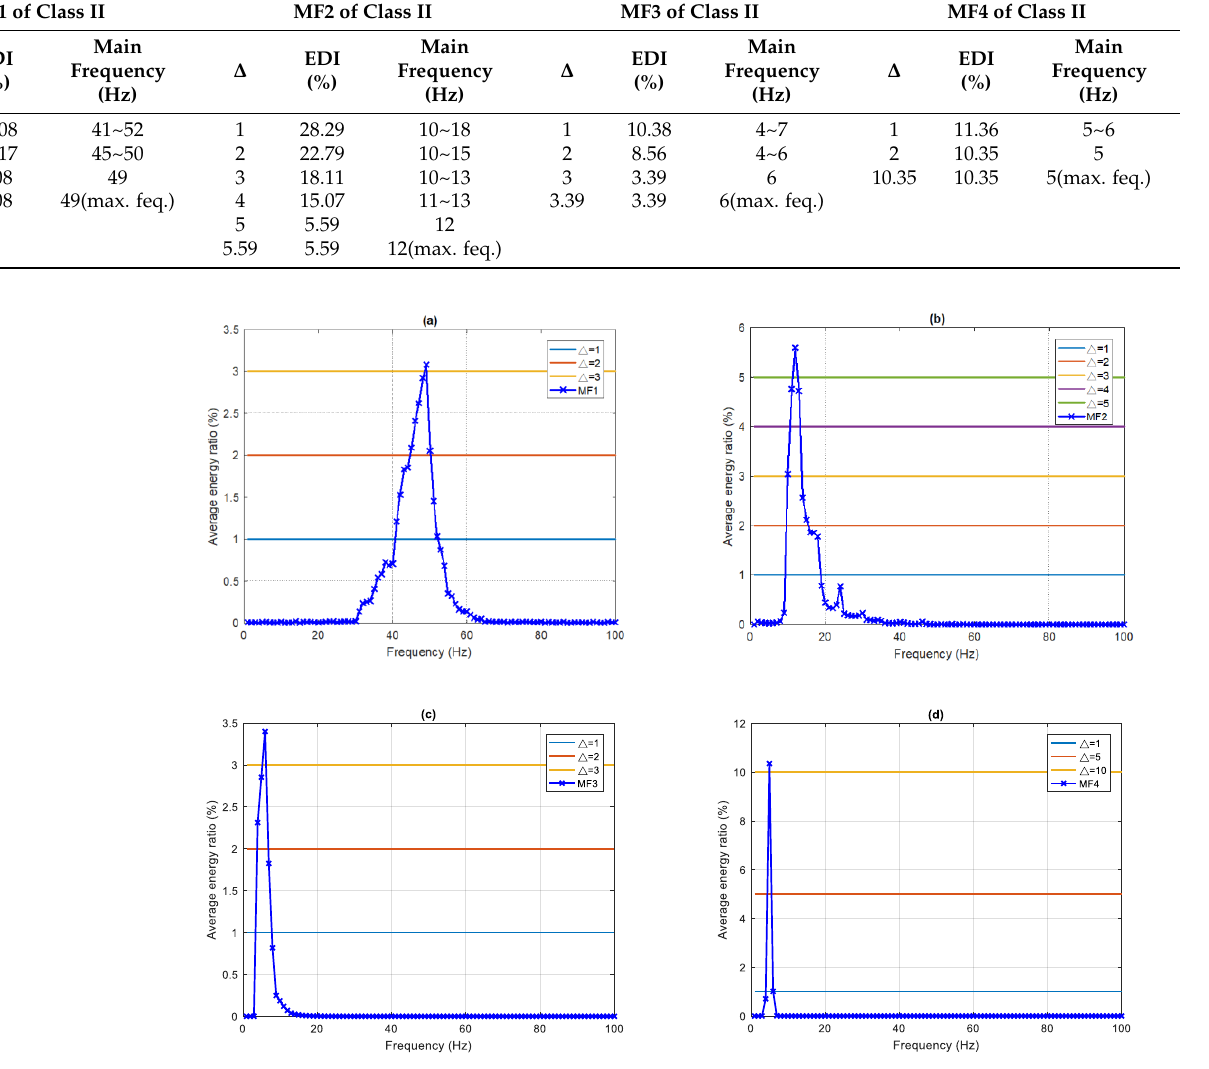
Figure 7. An average frequency – energy distribution of class II ( a ) MF1, ( b ) MF2, ( c ) MF3, and ( d )